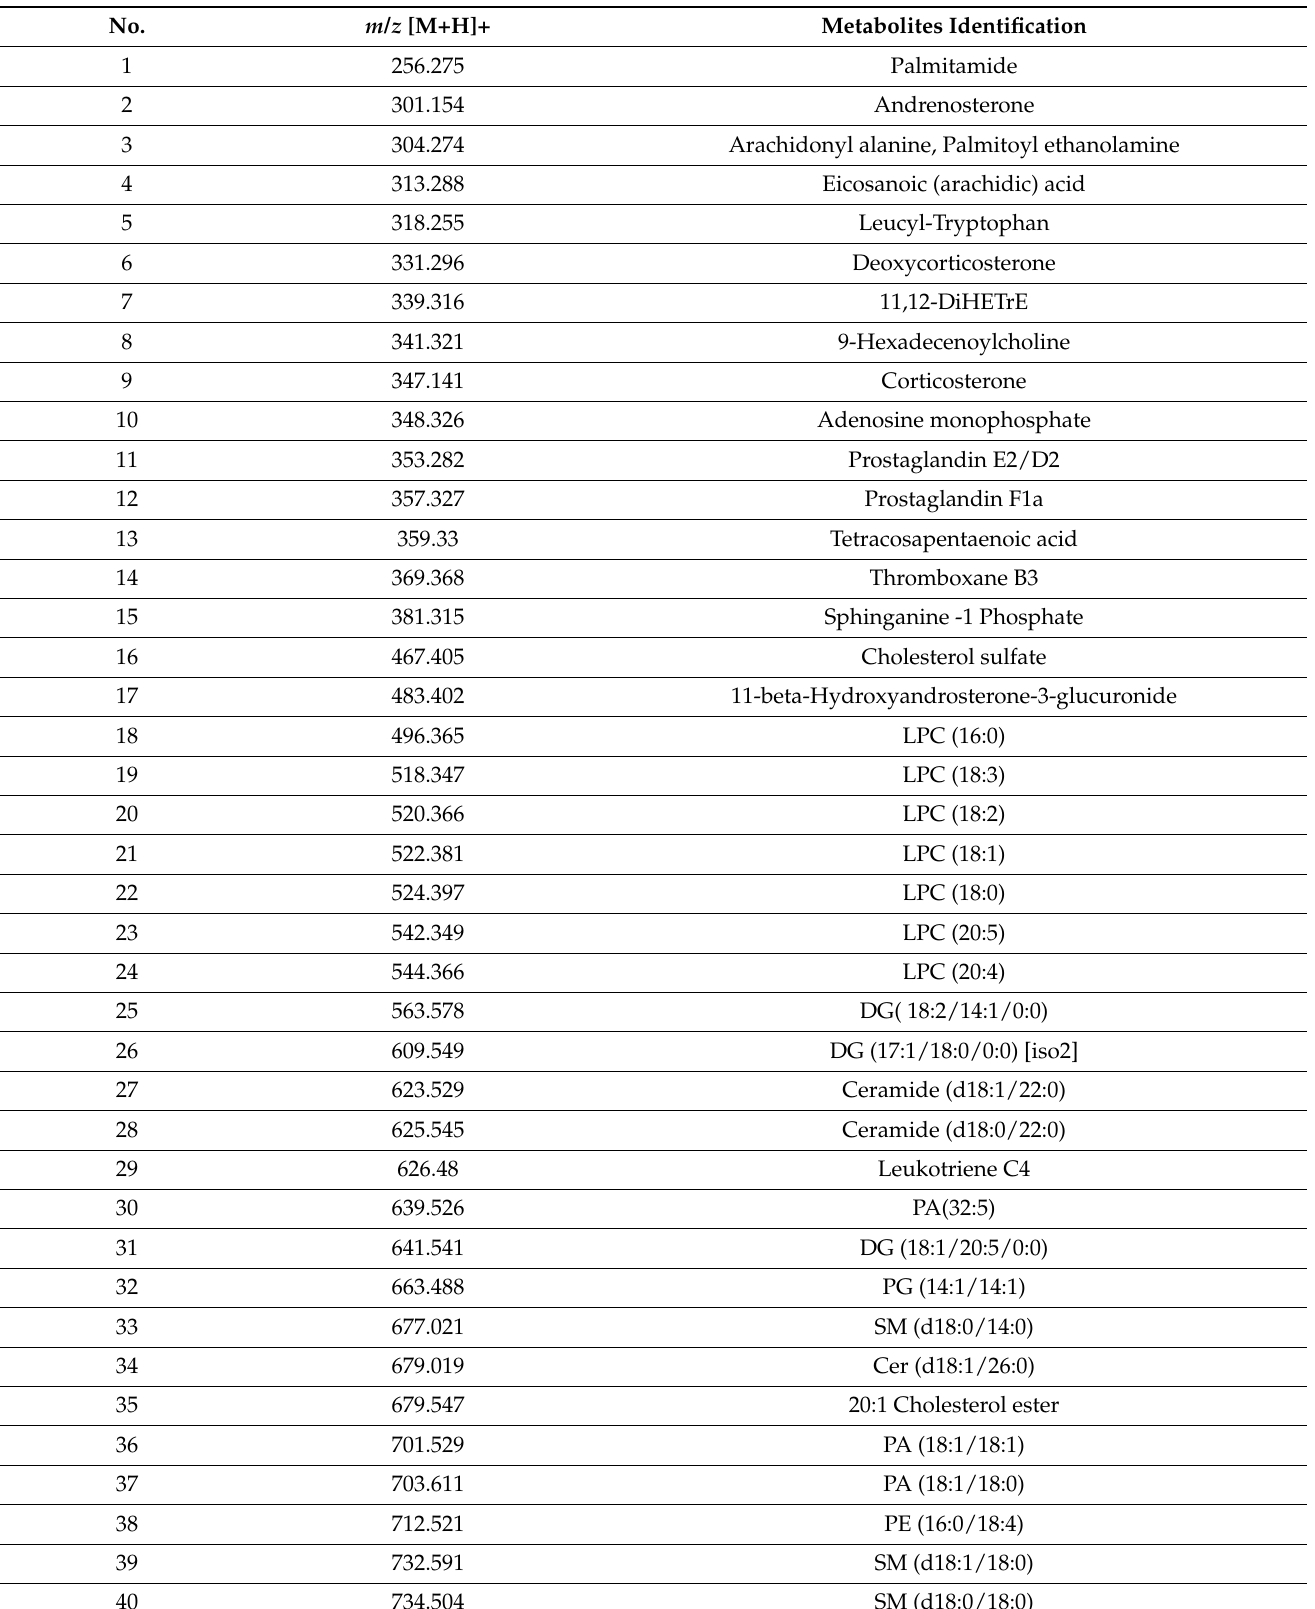
Table 1. The m/z values and putative identification of metabolites separated by